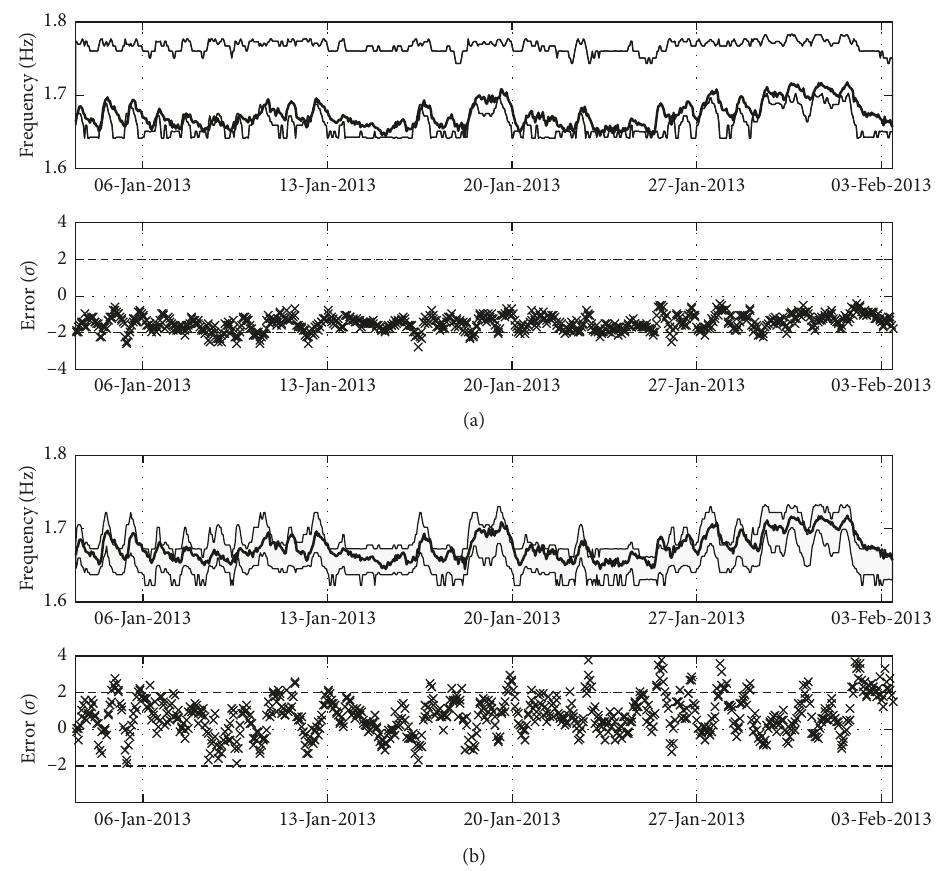
Figure 6: Observed values of structural modal frequency compared with predictions, considering (a) a learning phase including the frequency drop period and (b) a learning phase after removing the frequency drop period. Same symbols as for Figure